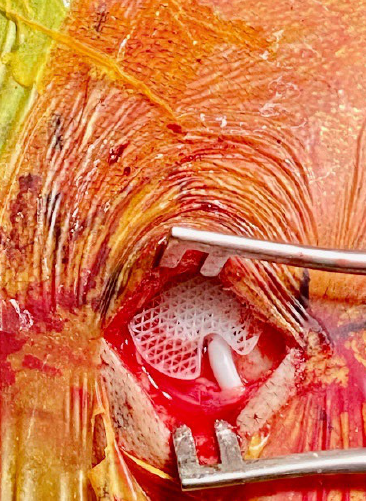
Figure 3. An intraoperative photograph of Design 2 inserted into a burrhole with a subdural drain visible.